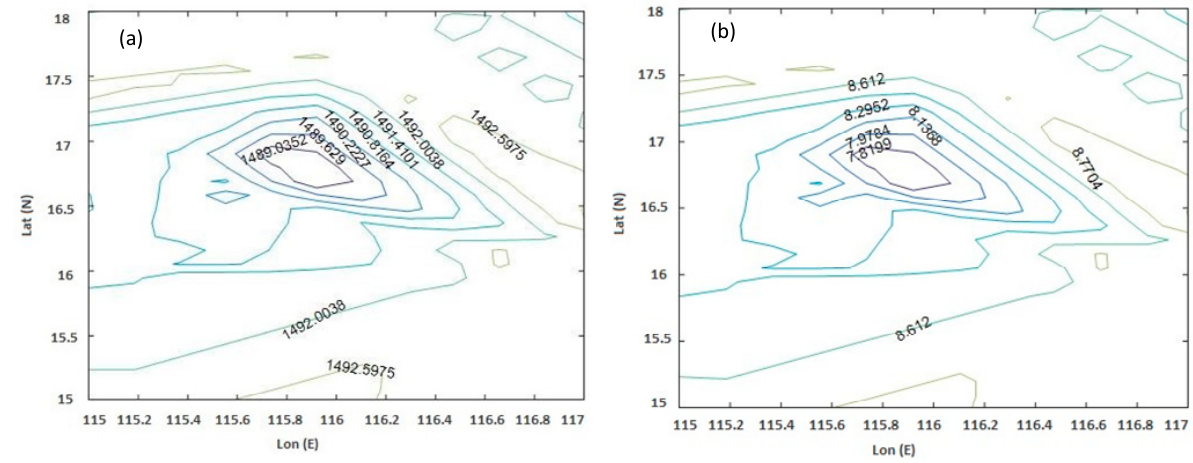
◦ C), contour lines map at 500 m depth.